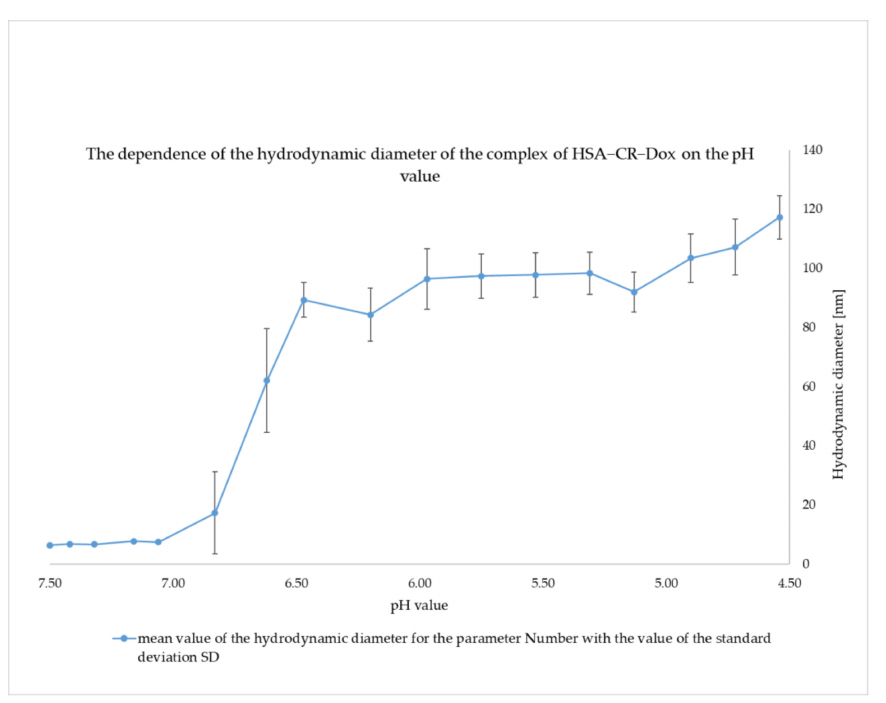
Figure 12. The dependence of the hydrodynamic diameter of the complex of has–CR–Dox on the pH value (mean ± SD, n =